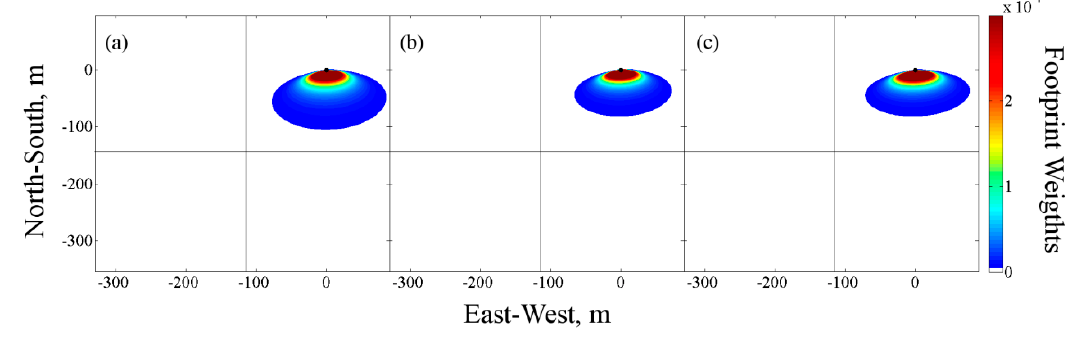
Figure 8. Contour plots of footprints at EC1 using the ( a ) S90, ( b ) H2000, and ( c ) KM01 models during unstable stratification on DOY 195 at 14:30 am